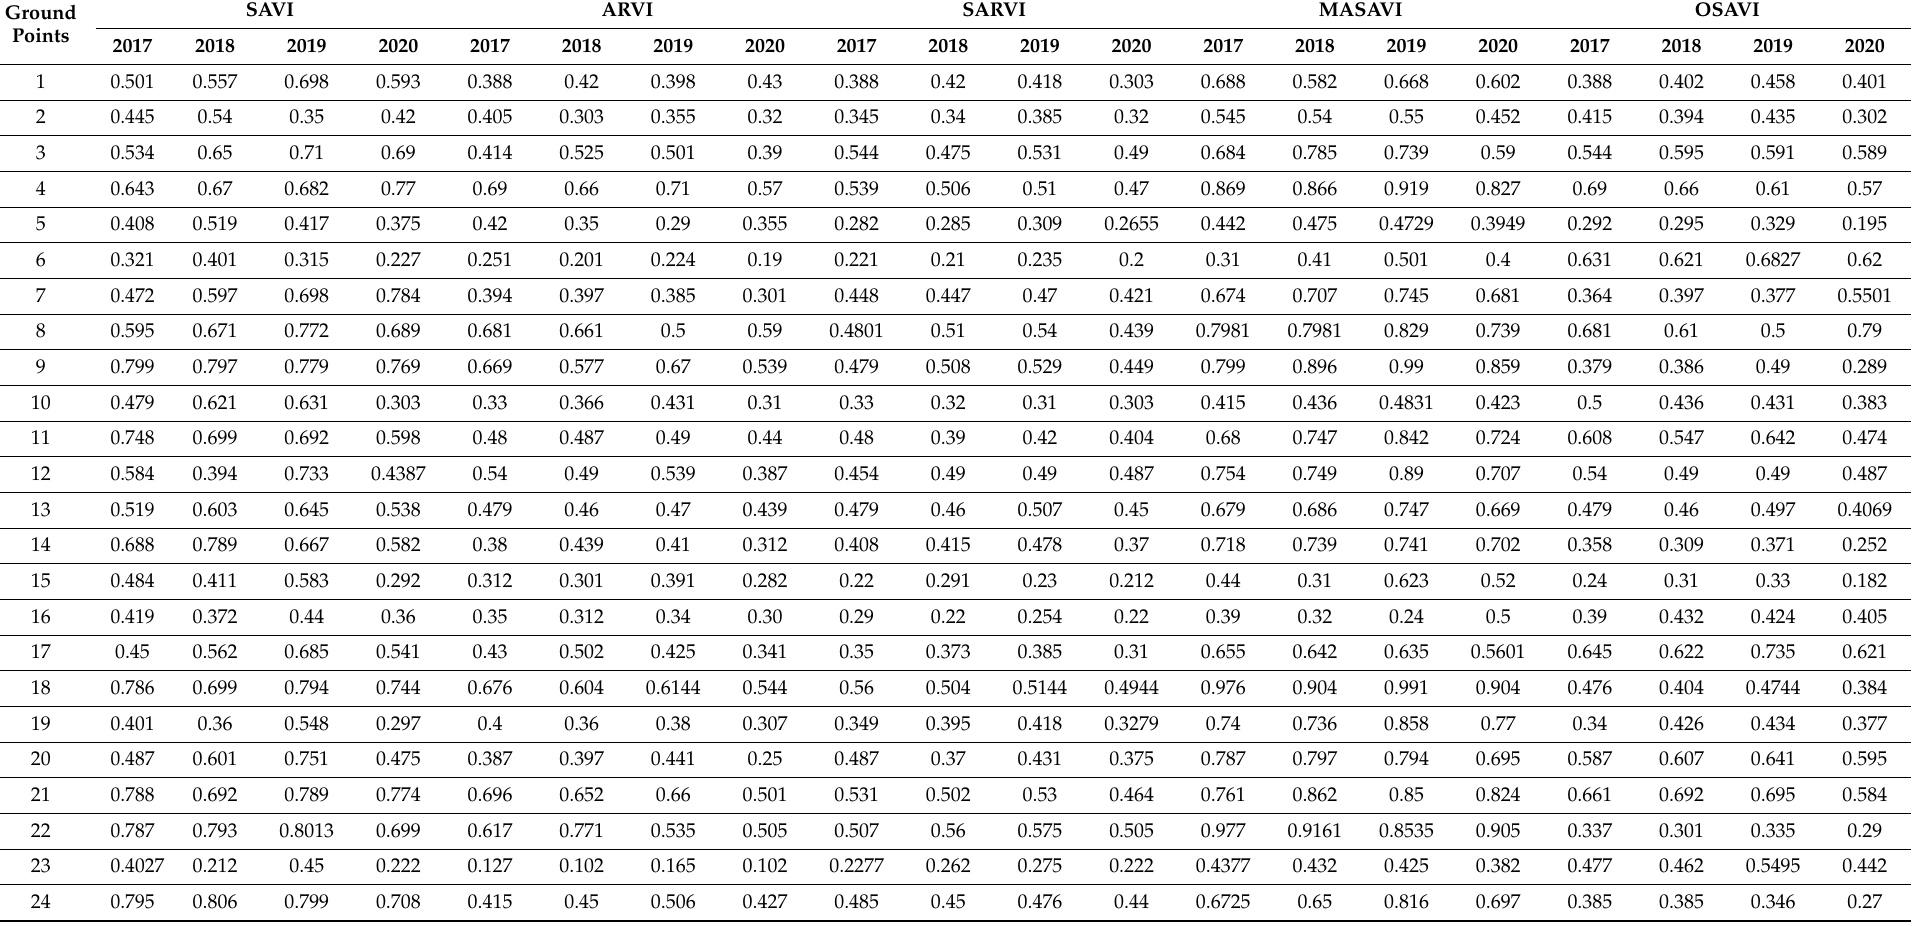
Table A1. SAVI, ARVI, SARVI, MSAVI and OSAVI from 2017–2020 for 36